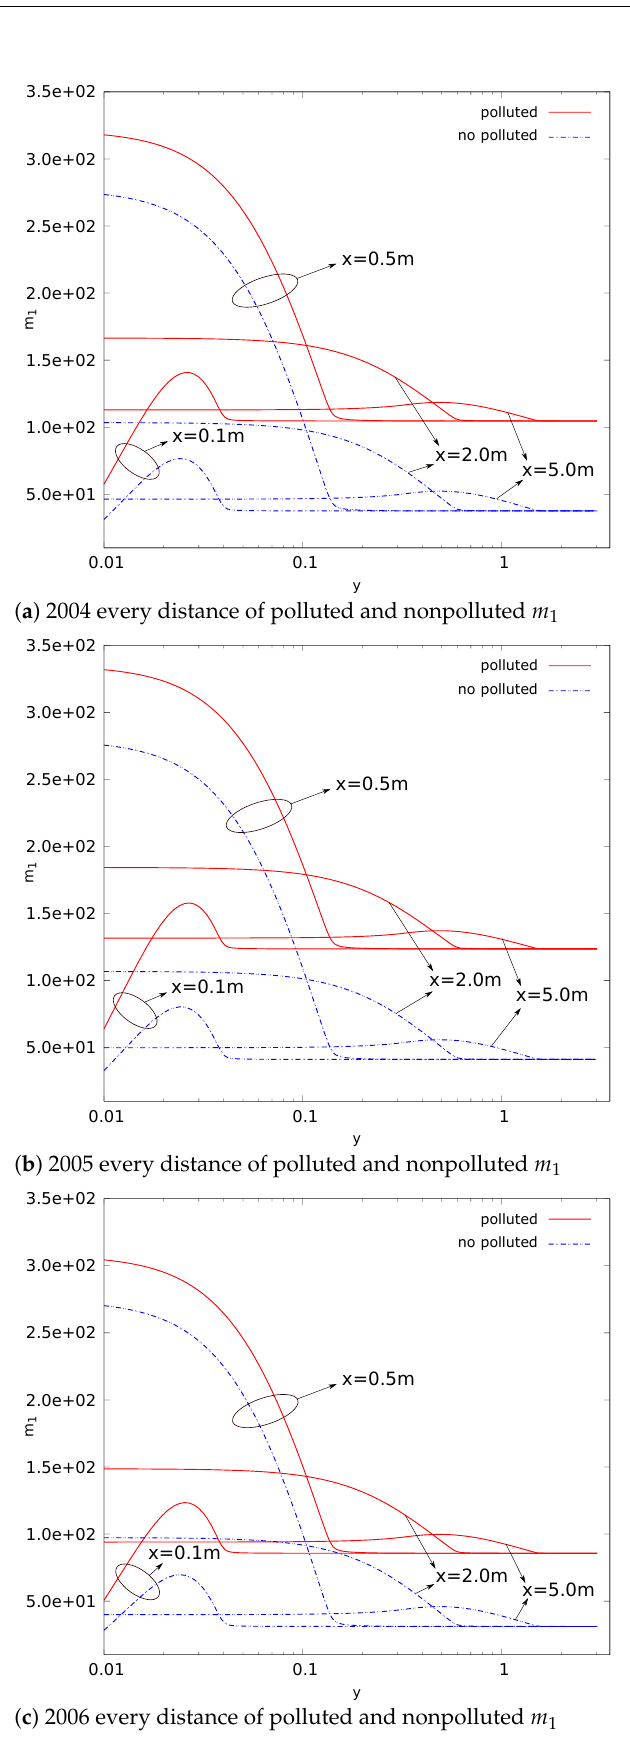
Figure 7. Status of m 1 over three